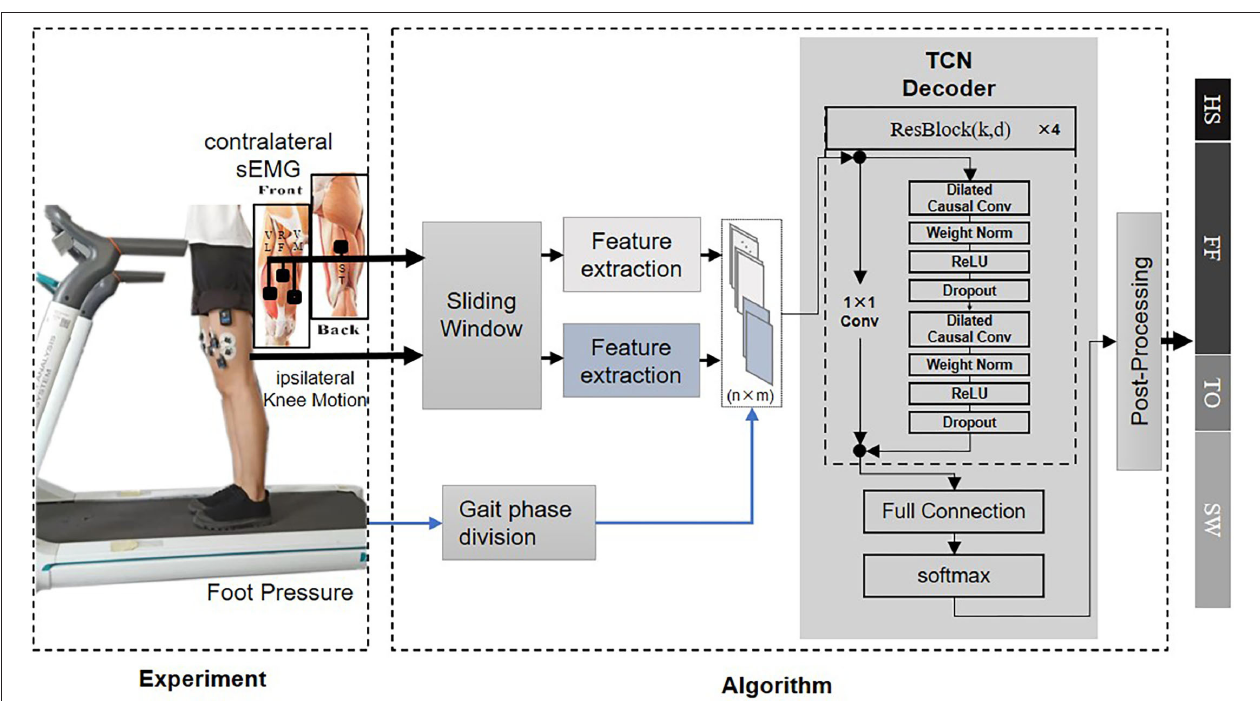
FIGURE 1 | Overview of the data acquisition scenario and architecture of the gait phase decoder in the offline mode. The decoder fuses simultaneous sensory feedback from the contralateral surface electromyography (sEMG) and the ipsilateral knee motion to generate an inference out of four-gait-phase categories which include HS (heel strike), FF (flat feet), TO (toe off), and SW (swing). The foot pressure is utilized for the labeling process. Front and rear view of four thigh muscles including Semitendinosus (ST), Rectus Femoris (RF), Vastus Medialis (VM), and Vastus Lateralis (VL) is inserted to exhibit the electrode placement. All the serially connected residual blocks (ResBlock for short) share the same structure, thus, only one block is unfolded for